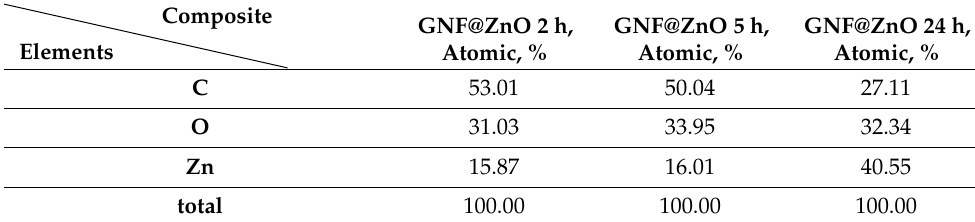
Table 1. Elemental composition of the studied samples.